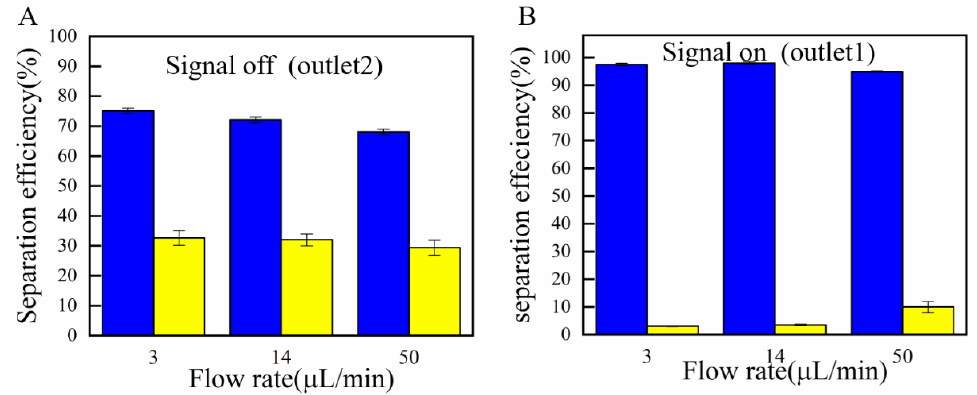
Figure 9. ( A ) The separation efficiency with pure inertial force. ( B ) The separation efficiency with combination of DEP force and inertial force.